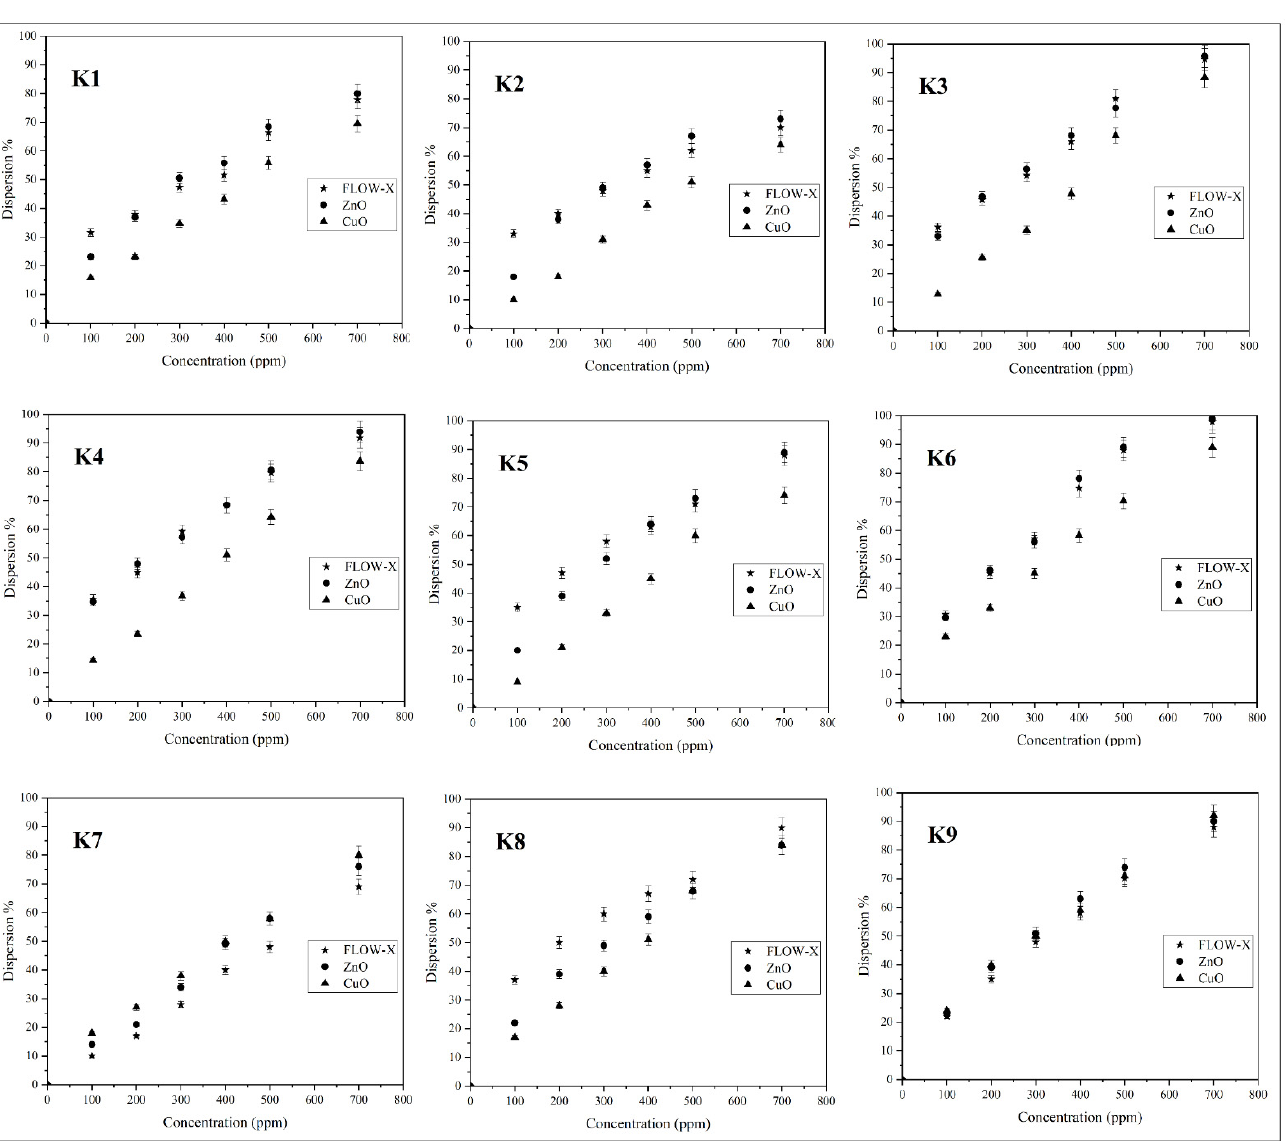
Figure 10. Asphaltene Dispersion percentages at different inhibitor concentrations for (K1 – K9).